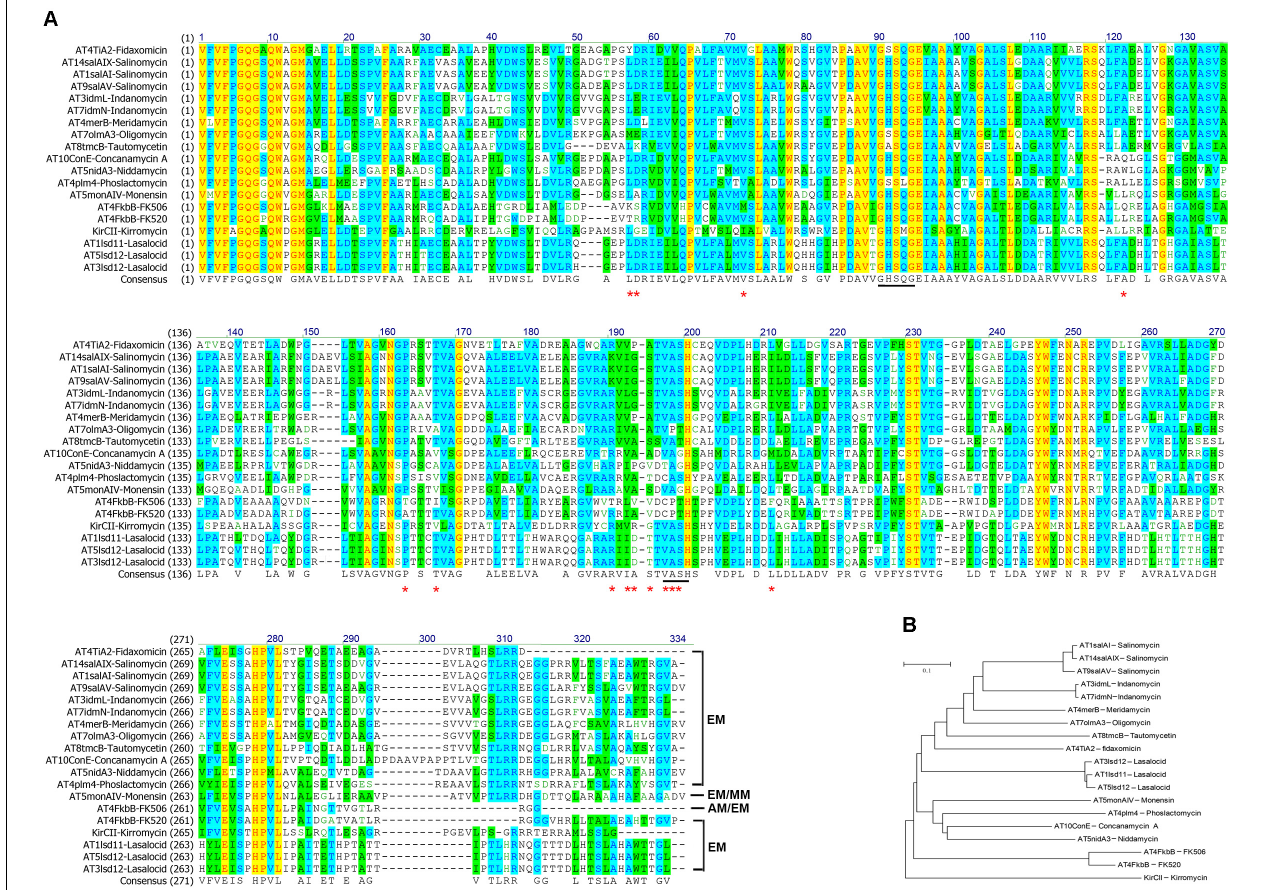
FIGURE 2 | Amino acid sequence alignments and phylogenetic tree of AT4 FkbB of FK506 PKS and ethmal-specific ATs. (A) Amino acid sequence alignments between AT4 FkbB and ethmal-specific ATs. Sequences colored in yellow and blue or green were corresponded to the results of identify positions and consensus positions. The residues in AT4 FkbB labeled by red stars were mutated to the correspondingly conserved residues in ethmal-specific ATs. The residues labeled by black line marks were the catalytic centers of ATs. (B) Phylogenetic tree of AT4 FkbB and ethmal-specific ATs. A phylogenetic tree was generated using Mega 5.05 neighbor-joining method. ATs are shown as the locations in PKSs and names of corresponding polyketides in parenthesis. The selection of 18 ethmal-specific ATs were from PKSs of FK520, fidaxomicin, lasalocid, monensin, kirromycin, phoslactomycin, meridamycin, salinomycin, indanomycin, oligomycin, tautomycetin, concanamycin A, niddamycin, and